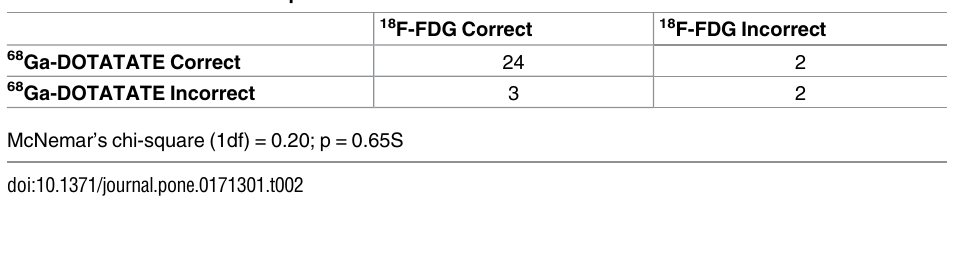
18 F-FDG SUVmax (cid:21) 2.5 or 68 Ga-DOTATATE SUVmax (cid:21) 1.5 defines a positive study.